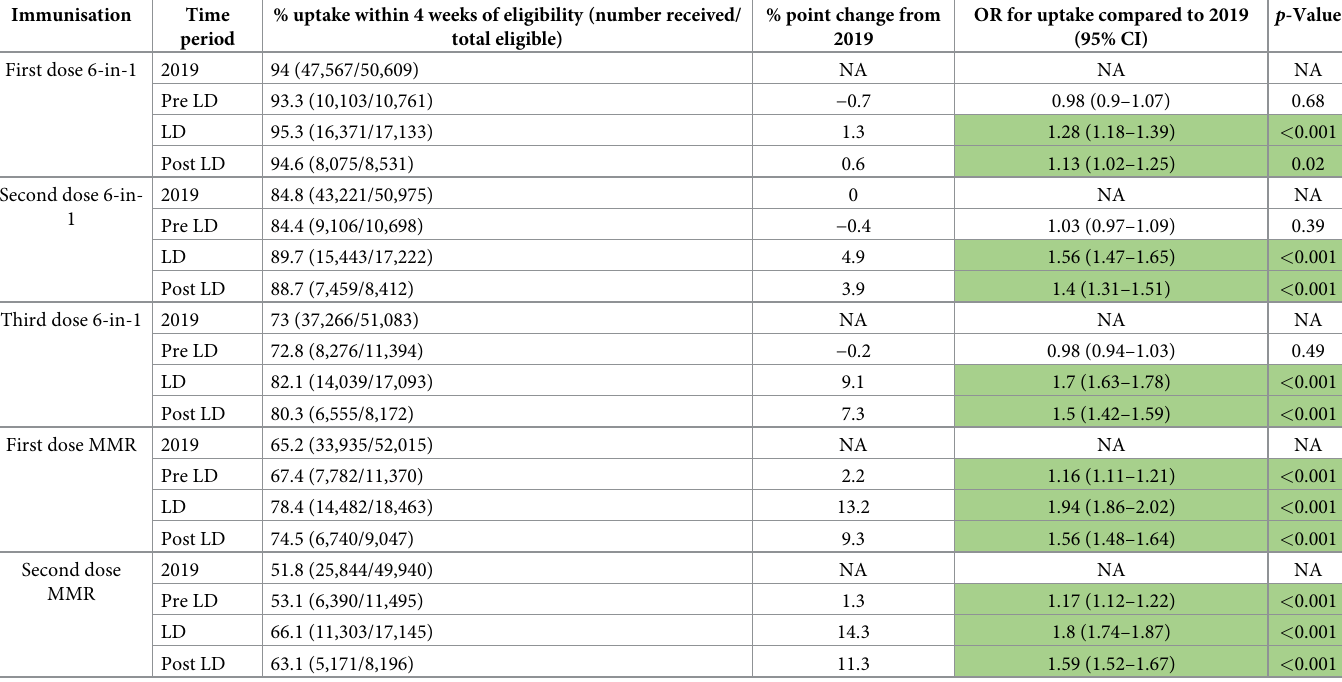
Table 1. Uptake of preschool immunisations in Scotland by time period with OR compared to baseline of 2019.